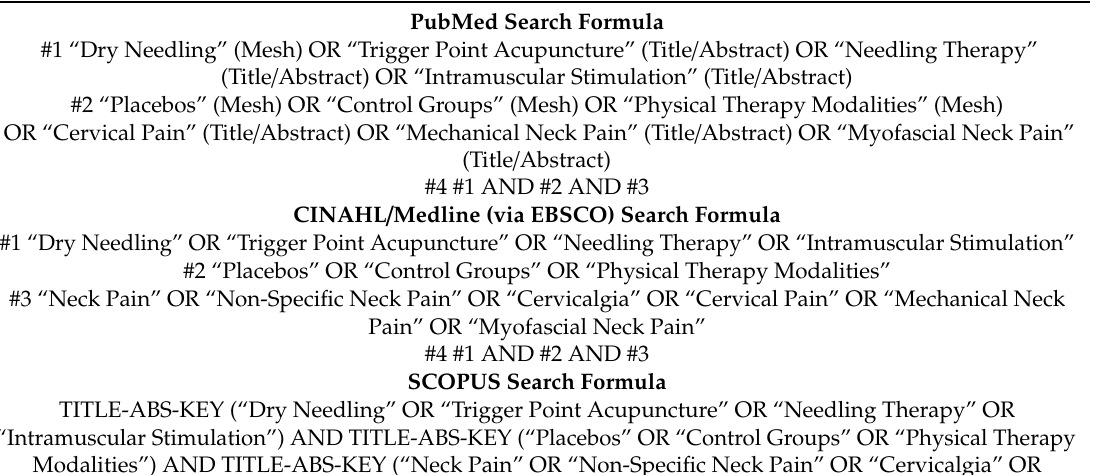
Table 1. Database formulas during the literature